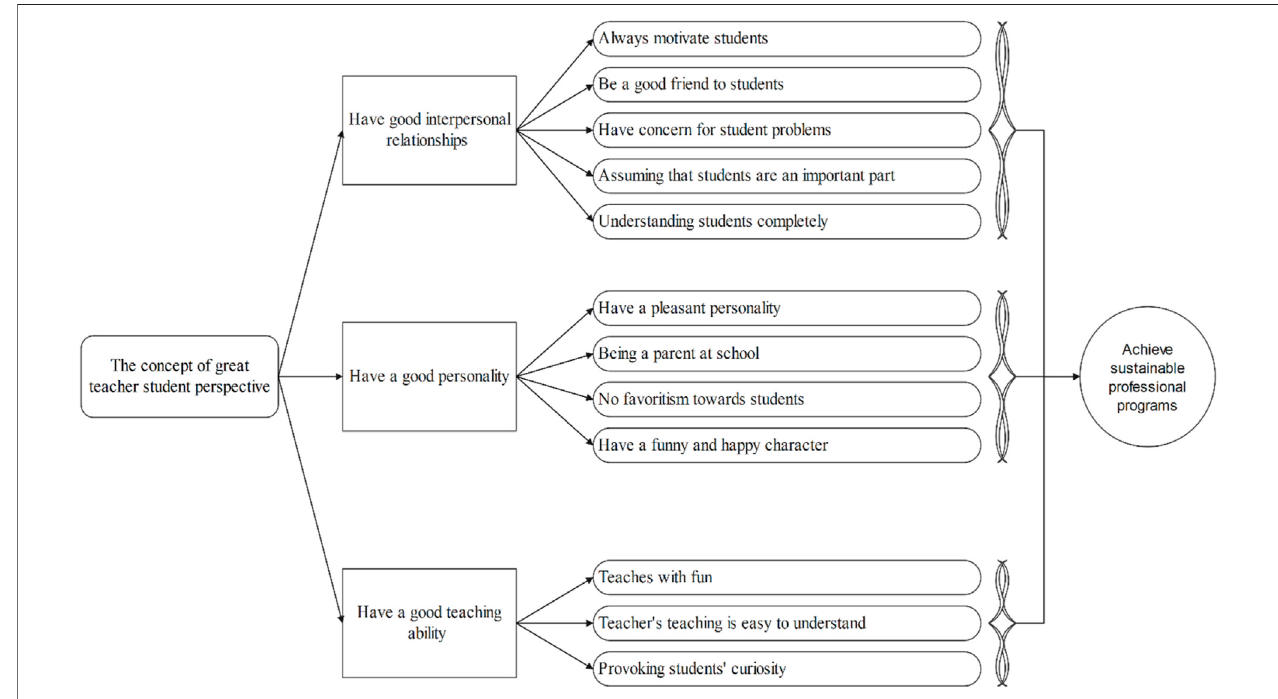
FIGURE 1 | The concept of great teacher student